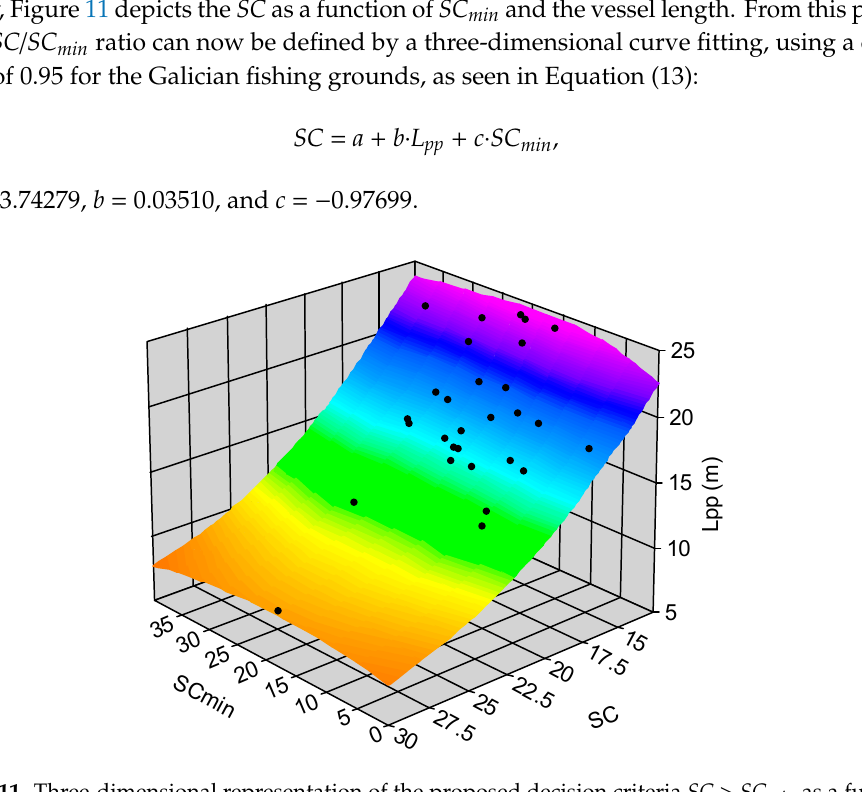
Figure 11. Three-dimensional representation of the proposed decision criteria SC > SC min as a function of each vessel length ( L pp ) .